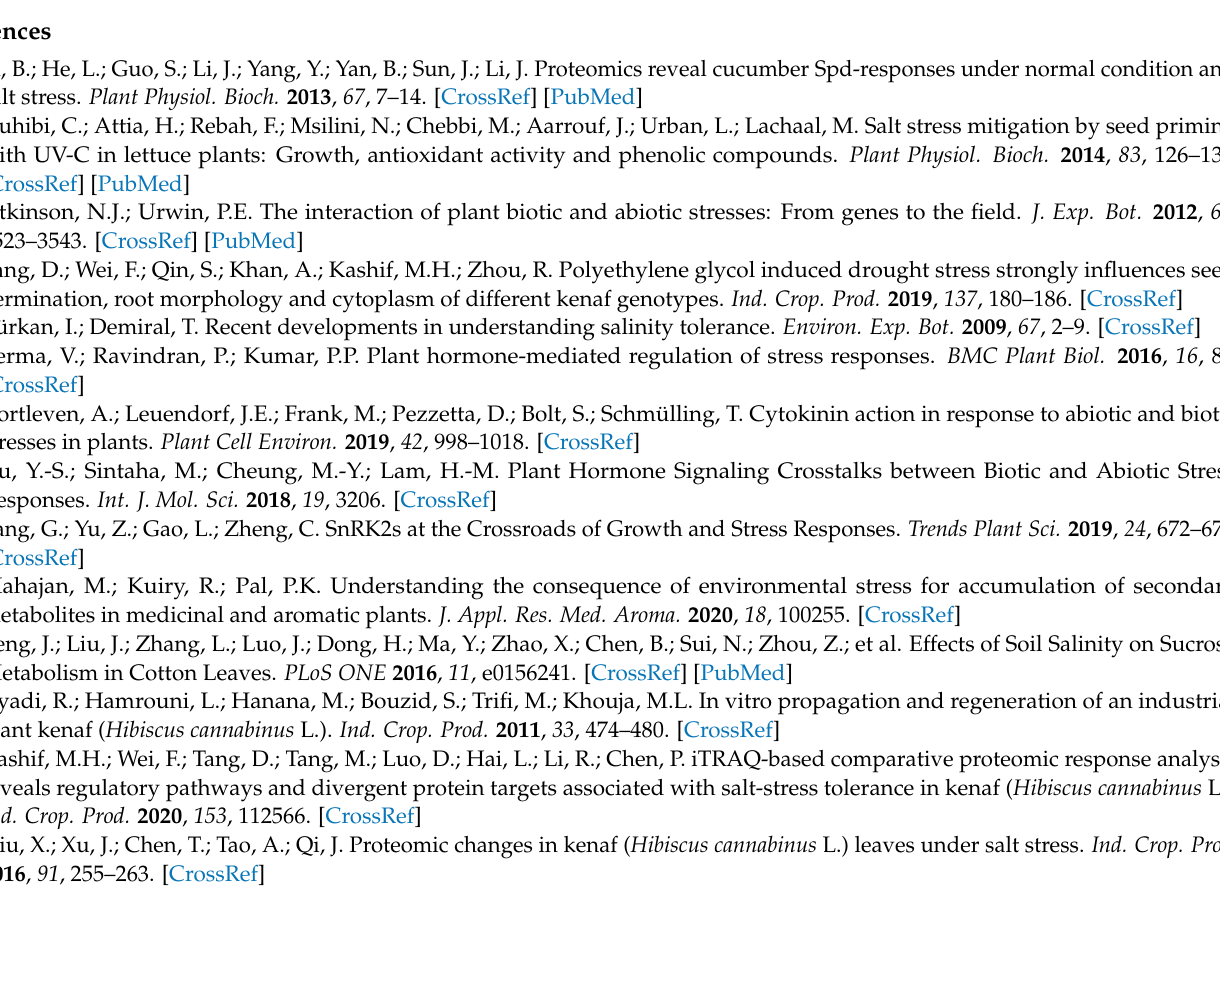
Table S3: The overall glimpse of metabolites detected in the current study, Table S4: Differentially enriched metabolites in each of the three kenaf stem parts, Table S5: Brief information of how the unigenes were annotated against the seven databases, Table S6: Primers for the randomly selected unigenes that conducting